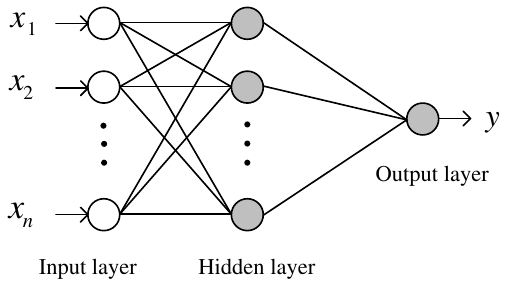
Fig. 2. A neural network with feed-forward architecture and one hidden